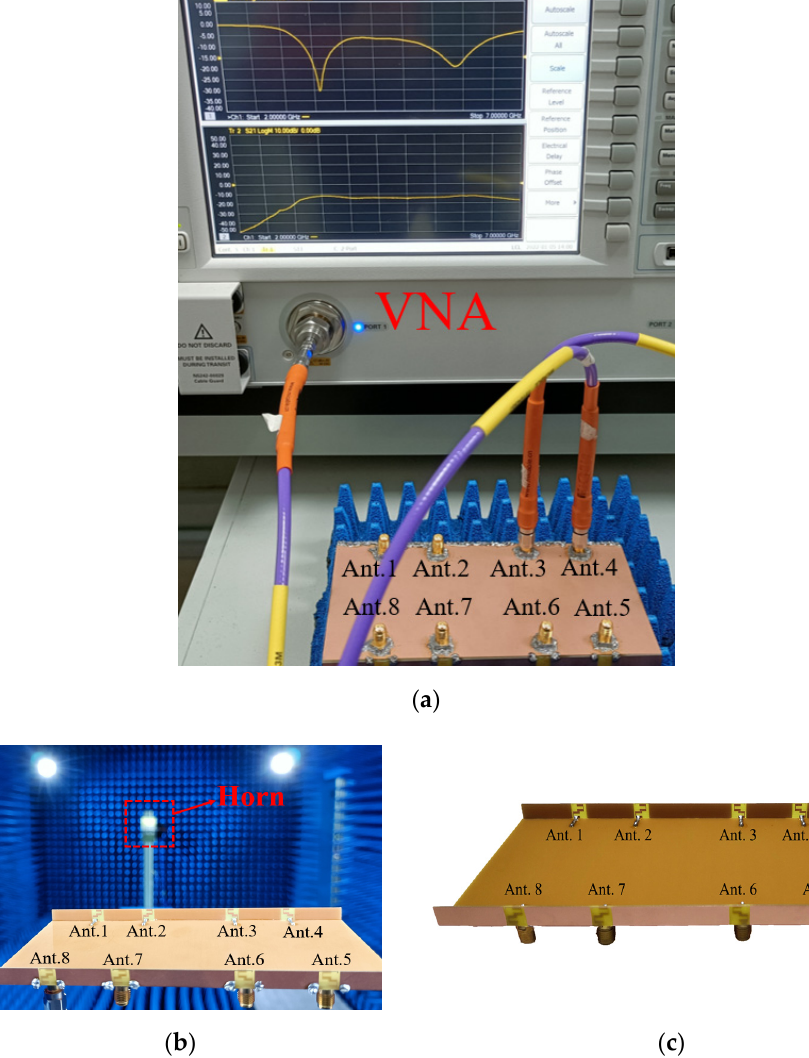
Figure 5. Photograph of the measurement setup; ( a ) vector network analyzer; ( b ) anechoic chamber; ( c ) fabricated antenna.